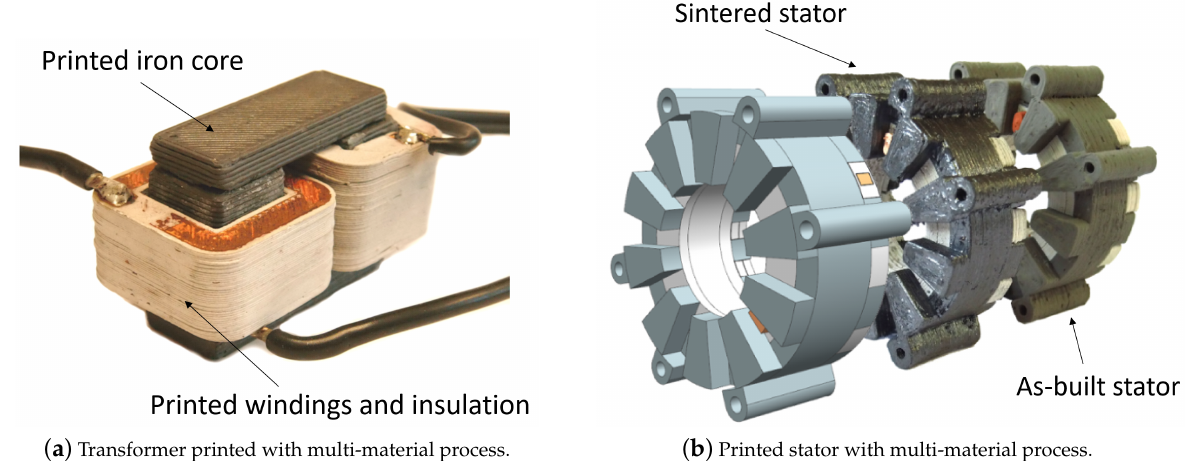
Figure 19. Examples of printing multiple key materials for electrical machines: iron core, conductors, and ceramic insulation